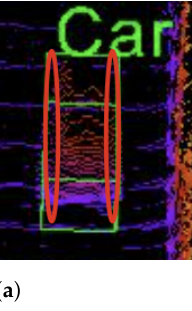
Figure 4. Comparison of 3D detection using: ( a ) a 2D bounding box; ( b ) 2D instance segmentation. Ellipses in Figure 4a denote the noise point clouds lying between the boundary and the bounding box of a certain